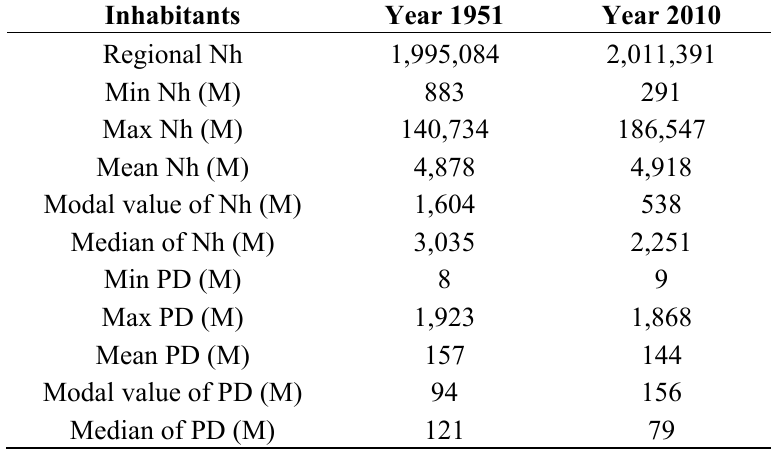
Table 3. Comparison between the Calabrian population data recorded in 1951 and 2010 [37]. Nh: number of inhabitants; (M): per municipality; PD: population density (Inhabitants/km 2